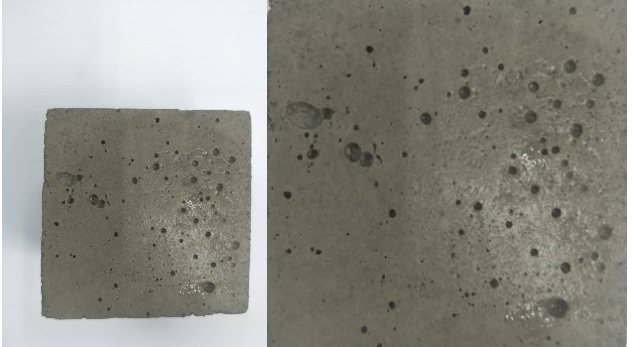
Figure 3. Original and modified images.